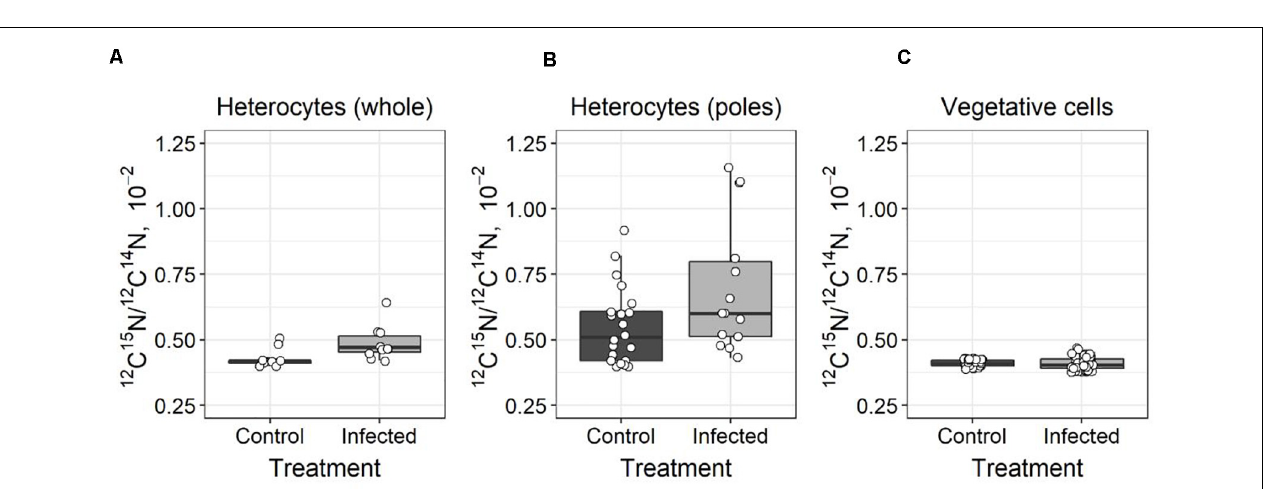
FIGURE 2 | Changes in nitrogen fixation (A) and nifH transcript abundance (B) in the control and infected cultures of the Aphanizomenon flos-aquae strain 2012/KM1/D3. Symbols indicate the mean values, and the error bar shows the standard deviation of three technical replicates.